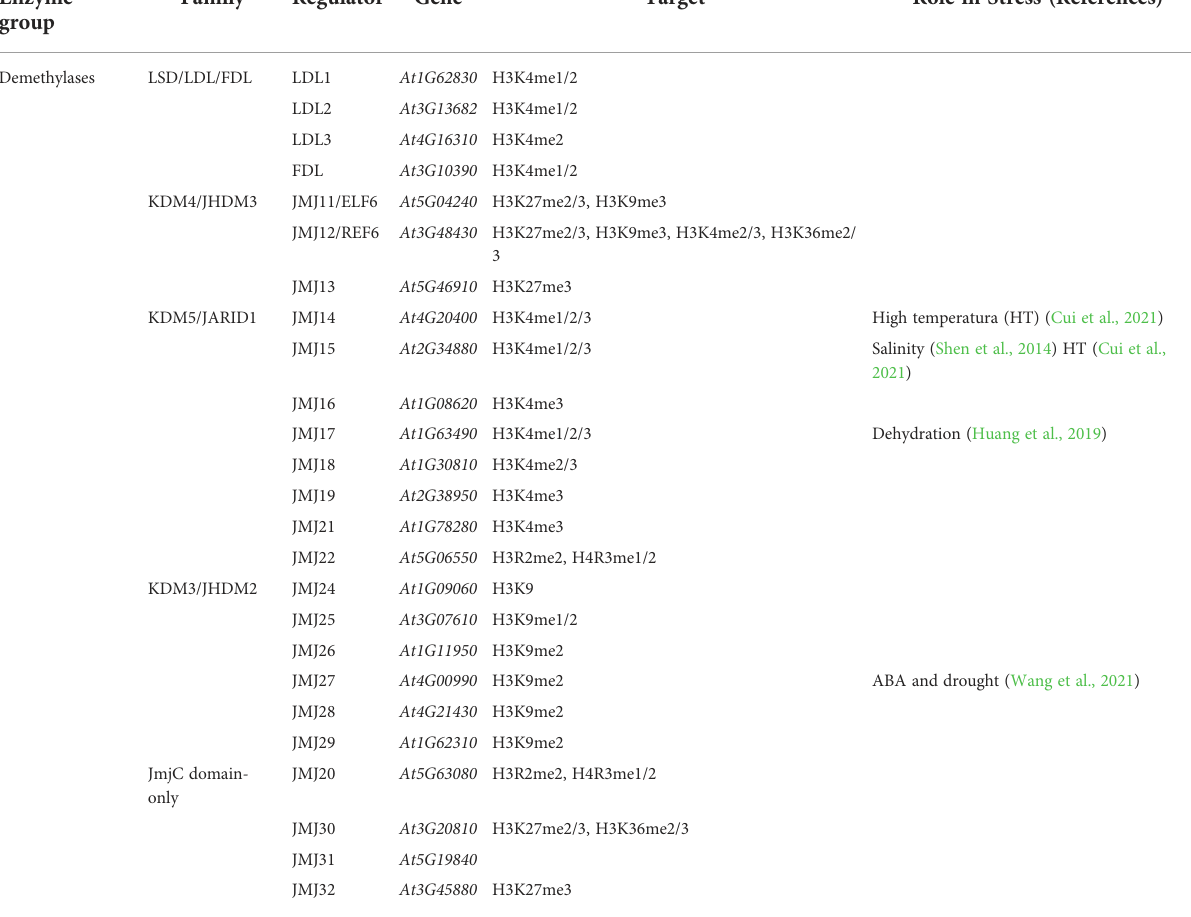
TABLE 5 Classi fi cation of histone demethylases in Arabidopsis . Enzyme